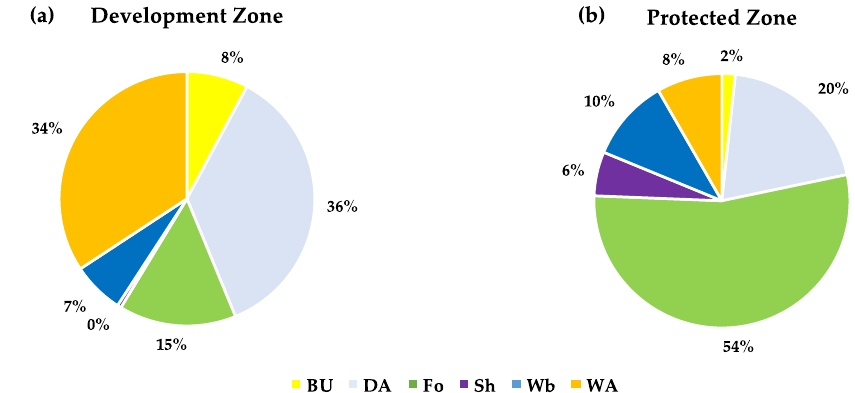
Figure 12. Percentage of land cover area in 2031: ( a ) in the development zone; ( b ) in the protected zone. Note: BU—built-up area; DA—dryland agriculture; Fo—forest; Sh—shrub; Wb—waterbody; and WA—wetland agriculture.